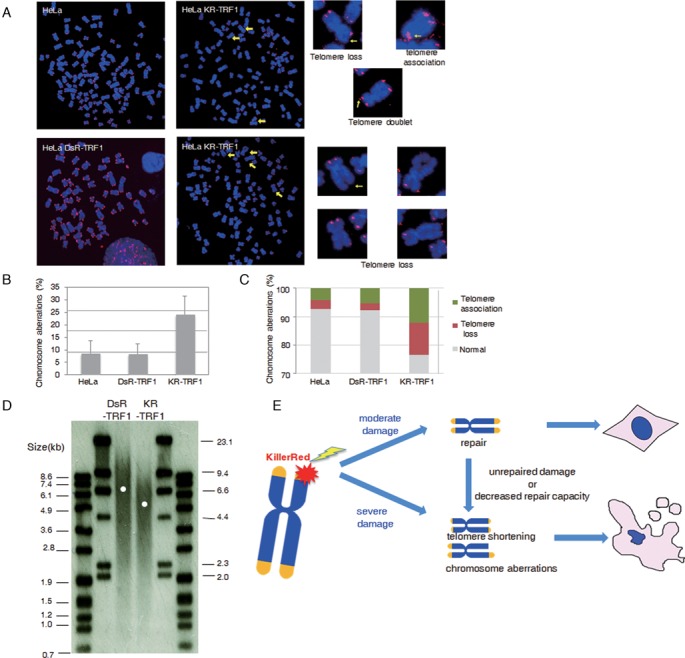
Telomere-specific DNA damage disrupts telomere integrity and accelerates telomere shortening. (A) Chromosomal aberrations found in HeLa cells expressing KR-TRF1. (B and C) Quantification of chromosomal aberrations from (a). Aberrations per chromosome (b) and percentage of each chromosomal aberration type (c) are shown. Data were derived from three independent experiments (n = 2000). (D) TRF analysis of average telomere length in HeLa cells. (E) A model depicting oxidative DNA damage at telomeres leading to cell death. Abbreviation lists: KR-TEL, KillerRed induced DNA Damage at Telomeres; ROS, reactive oxygen species; KR, KillerRed; tetR, tetracycline repressor; TA, transcription activation; TRE, tetracycline responsive element; PNA, peptide-nucleic acid; BER, base excision repair; PARP, Poly (ADP-ribose) polymerase; PAR, poly ADP-ribosylation; SSBs, single strand breaks; DSBs, double strand breaks; DDR, DNA damage response; oxo-G, 8-oxo-guanine; TRF1, telomere repeat binding factor 1; TRF2, telomere repeat binding factor 2; high LET, high linear energy transfer.